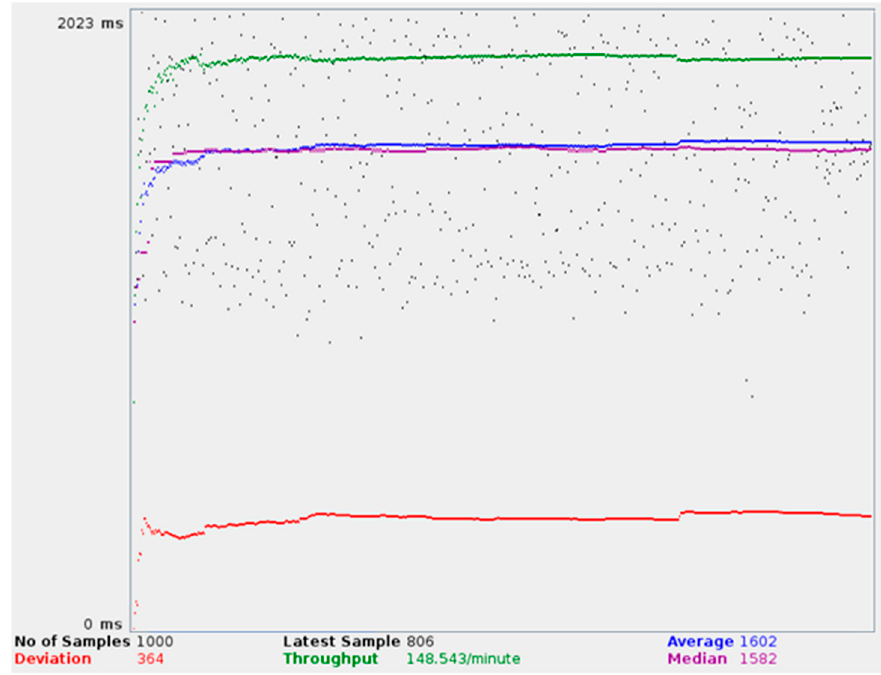
Figure 7. Middleware performance in the Steinkjer pilot. Note the deviation (red), average (blue) and median (purple) lines reflecting the value of the parameters